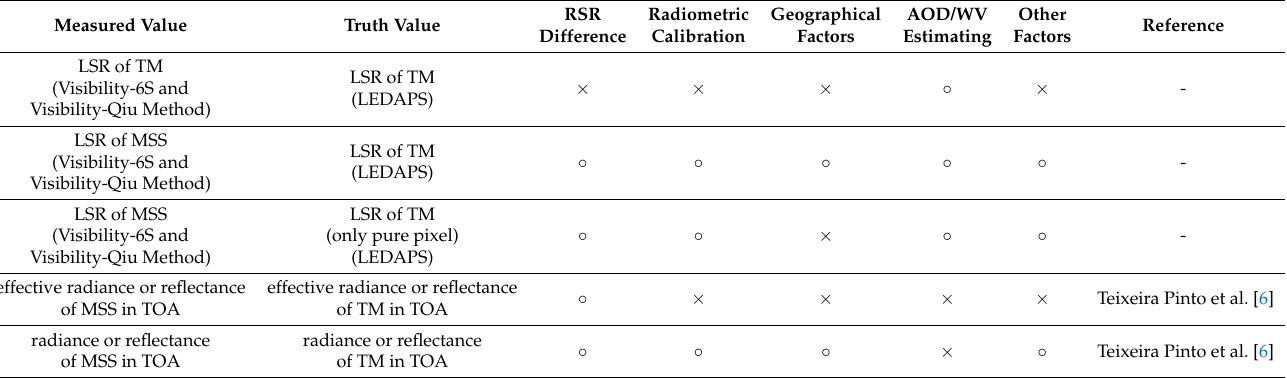
Table 2. The sources of